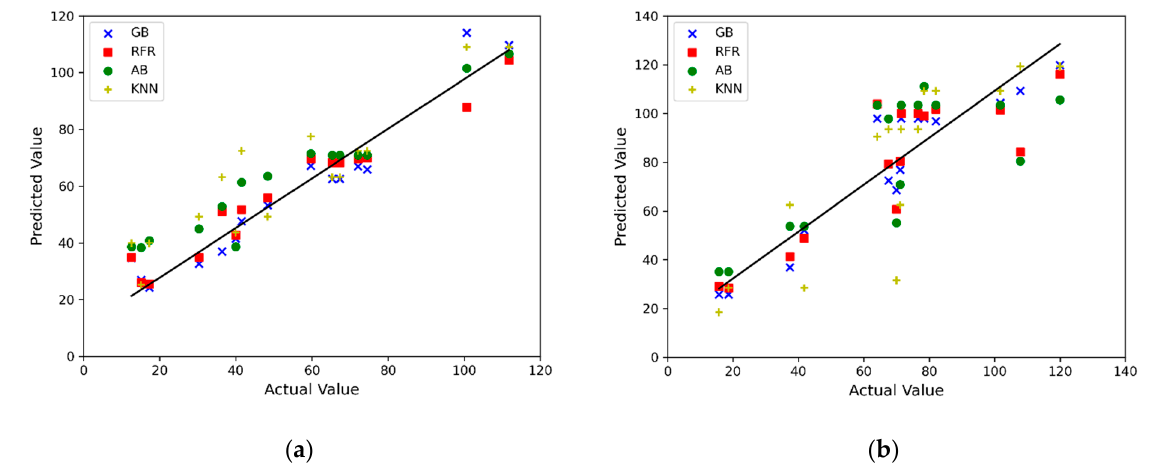
Figure 12. Predicted vs. actual values of ( a ) PV and ( b ) AV of the testing dataset for different algorithms (GB: Gradient Boosting, RFR: Random Forest, AB: AdaBoosting, kNN: k-Nearest Neighbor) for high shear rate.